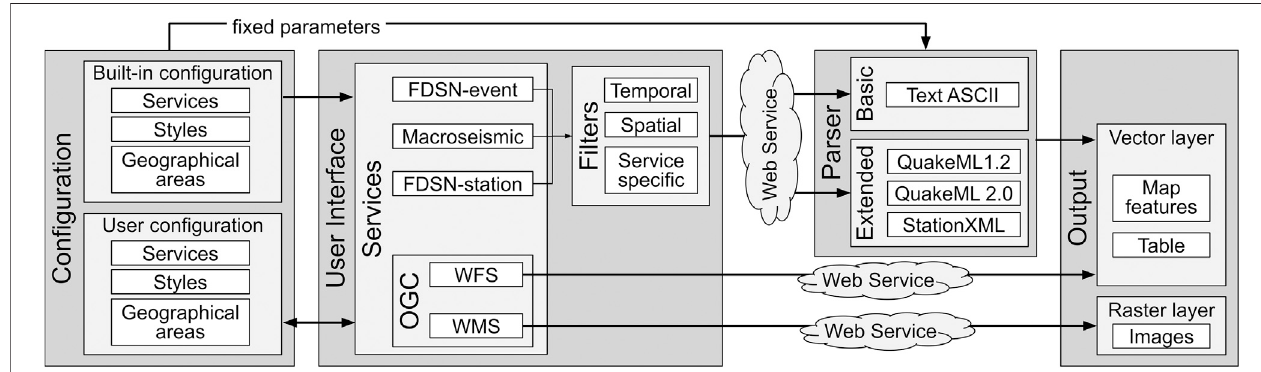
FIGURE 1 | Simpli fi ed structure of the plugin main components and their